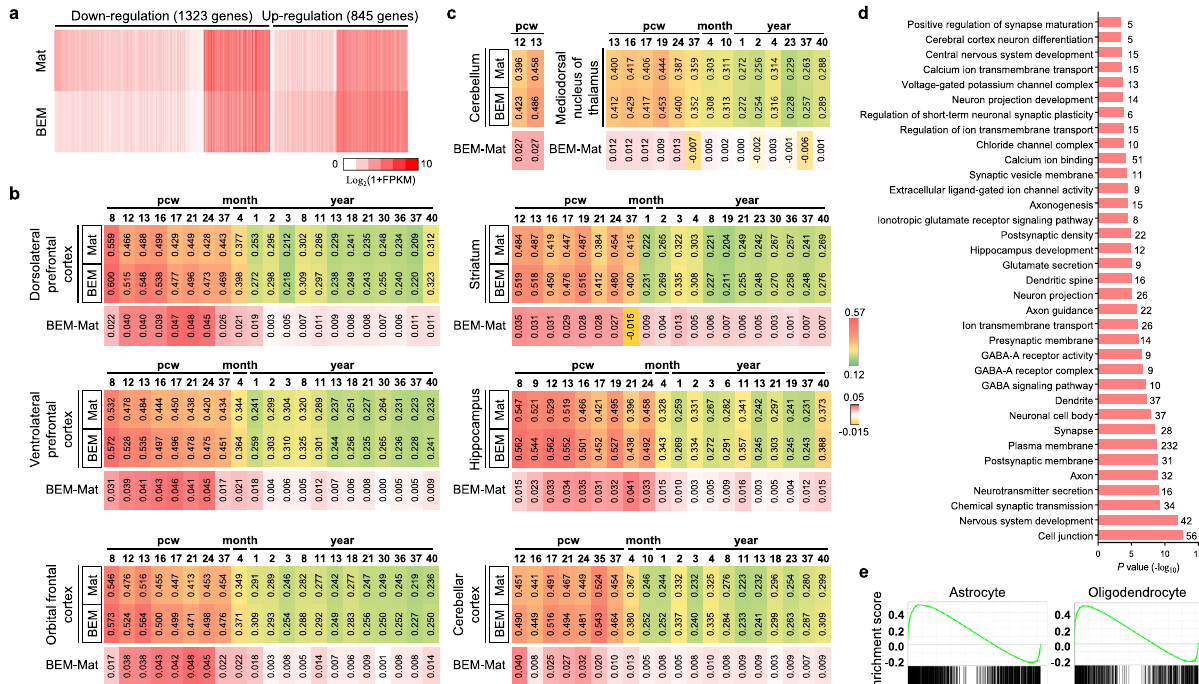
Fig. 3 The genome-wide transcriptome analysis of 75-day brain organoids. a Heatmap showing the expression of differentially expressed genes (DEG) between Mat and BEM organoids ( n = 3 per group, independent replicate = 1). b , c Heatmaps of Pearson ’ s correlation analysis of RNA-sequencing datasets of the Mat and BEM organoids for comparison with published transcriptome datasets of ( b ) three different human frontal regions across different stages and ( c ) fi ve different regions of the brain at fetal and postnatal stages. Values in the heatmaps of Mat and BEM groups dictate Pearson ’ s correlation coef fi cients (PCC). Values in the heatmaps of BEM-Mat indicate the differences in PCC between BEM and Mat groups. d The 35 enriched gene ontology (GO) terms of upregulated genes in BEM organoids versus Mat organoids (shown in terms of p -values). Numbers on the right-hand side of the bar indicate the number of DEGs within the GO terms. e The gene set enrichment analysis (GSEA) of the astrocyte and oligodendrocyte probe sets in the BEM group versus the Mat group. Mat and BEM organoids were cultured in a dish on an orbital shaker. Source data are provided as a Source Data fi